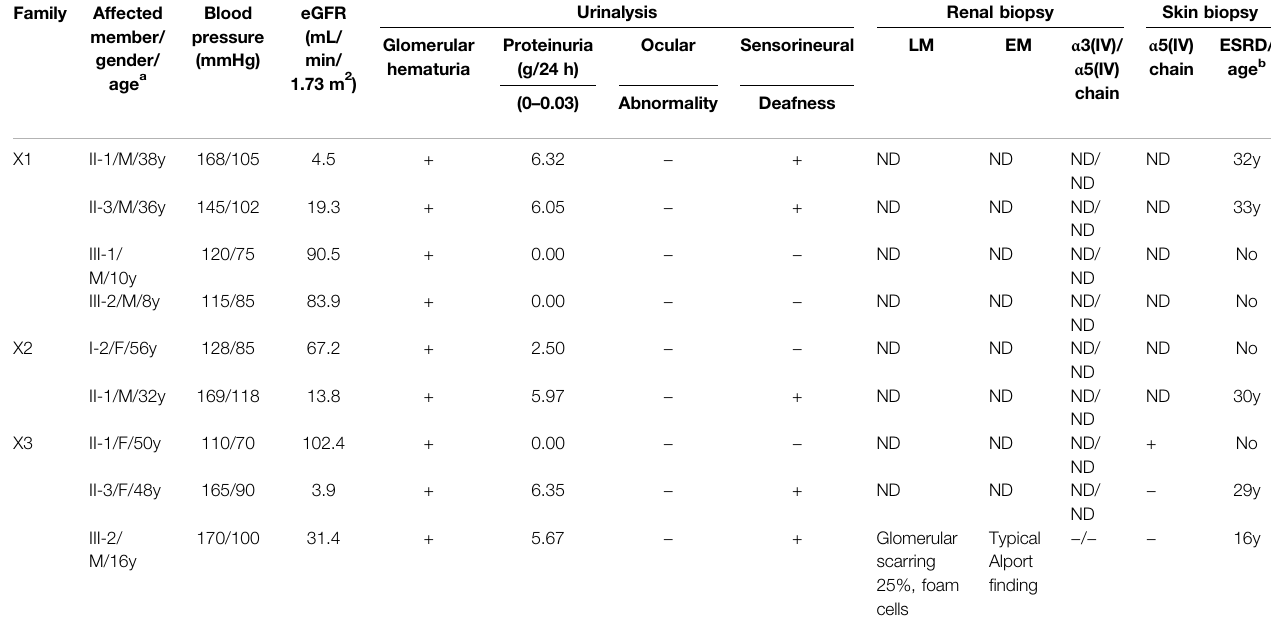
TABLE 1 | Clinical manifestations of affected individuals in families X1-X3.